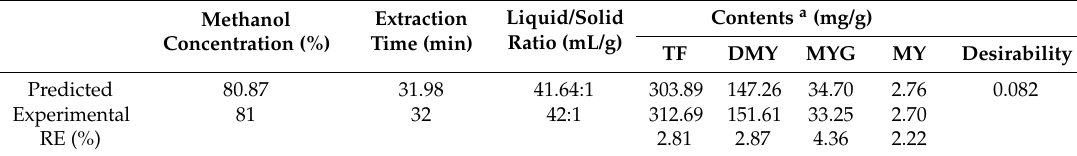
Table 4. Contents of the total flavonoids, dihydromyricetin, myricitrin and myricetin in Ampelopsis grossedentata leaves from different origins.